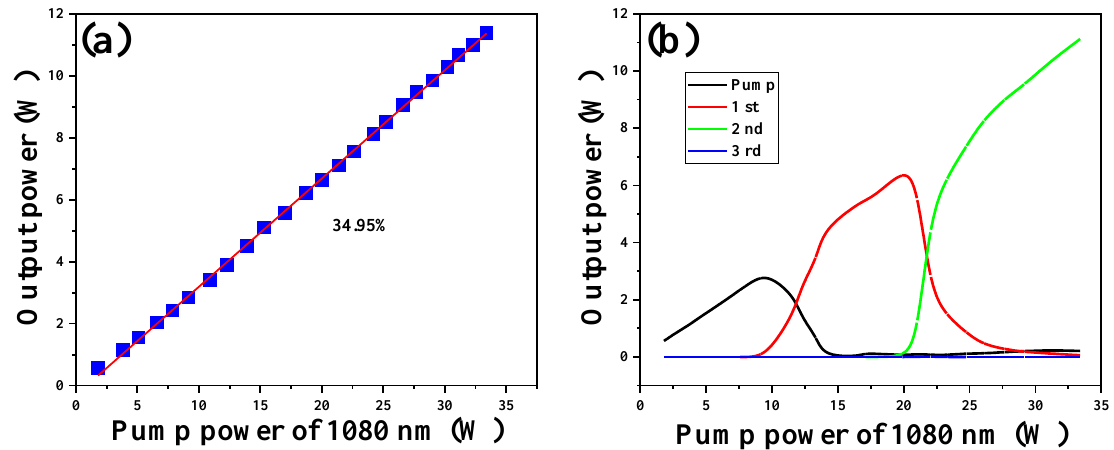
Figure 3. ( a ) Output power of the Raman laser versus the 1080-nanometer fundamental laser. ( b ) The evolution of Raman laser.